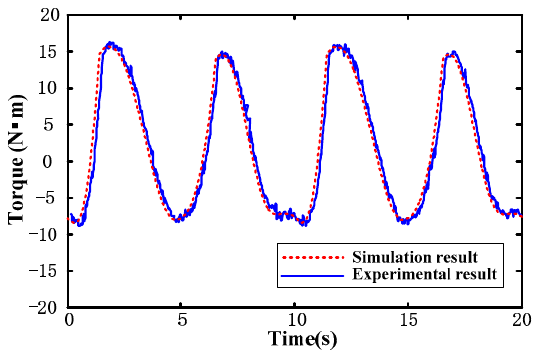
Figure 7. Mechanical-hydraulic system output torque dynamic change curve when wind speed is 9 m/s.